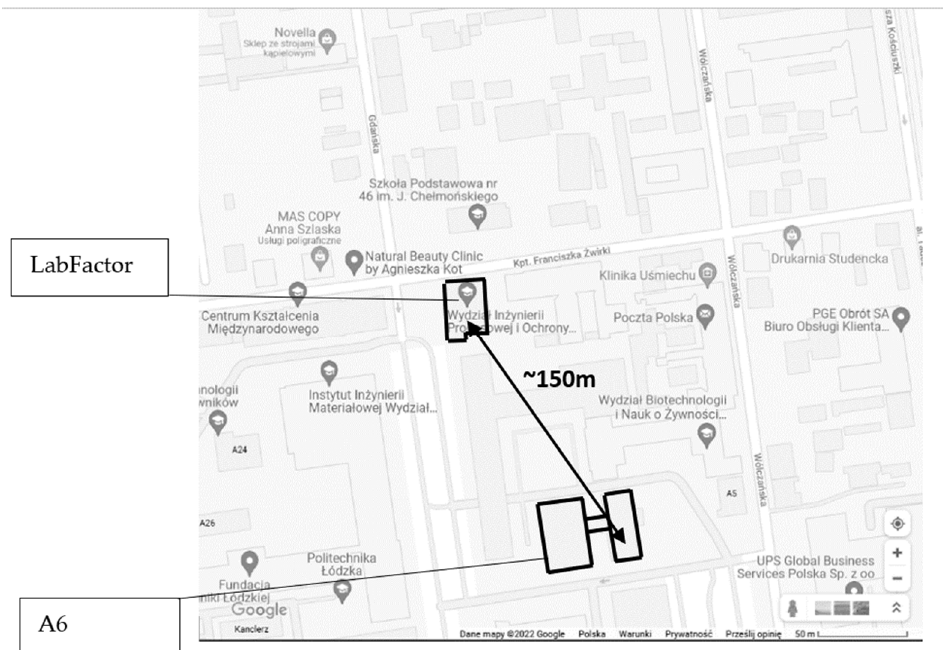
Figure 5. Map showing the LabFactor building and A6 building on the Campus of Lodz University of Technology (Source: [23]).